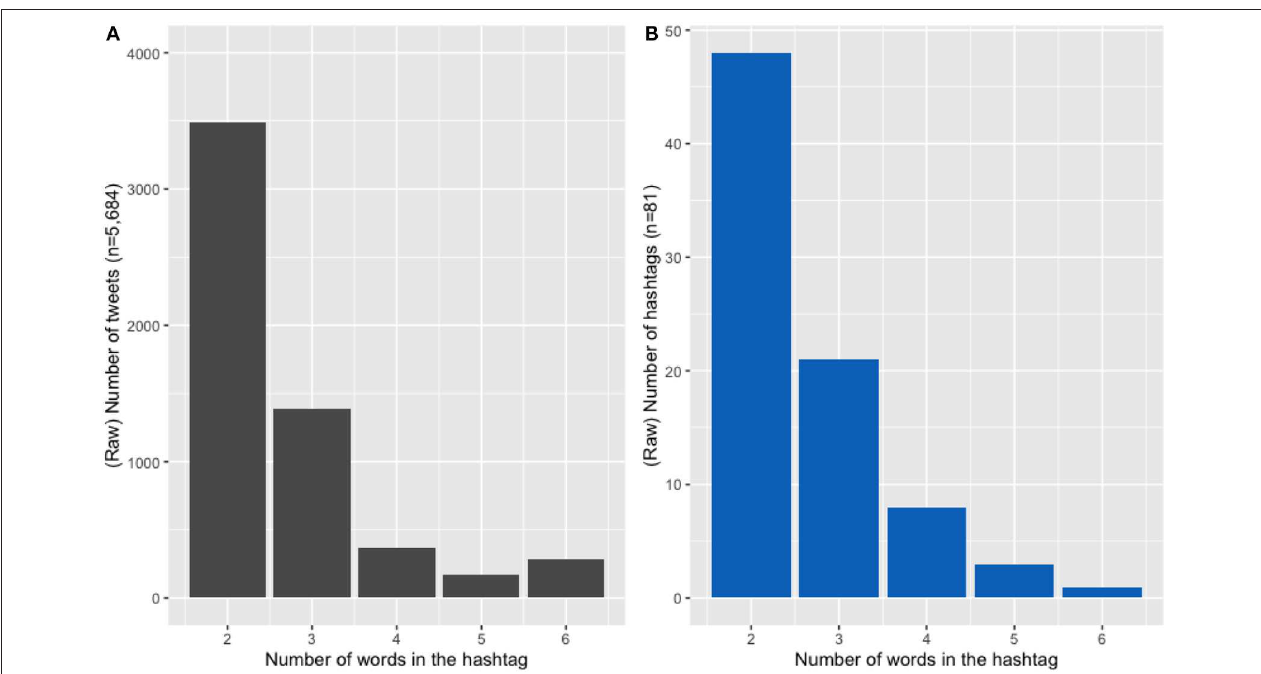
FIGURE 1 | (A) Distribution of hashtag length across number of tweets. (B) Distribution of hashtag length by (hashtag) type.